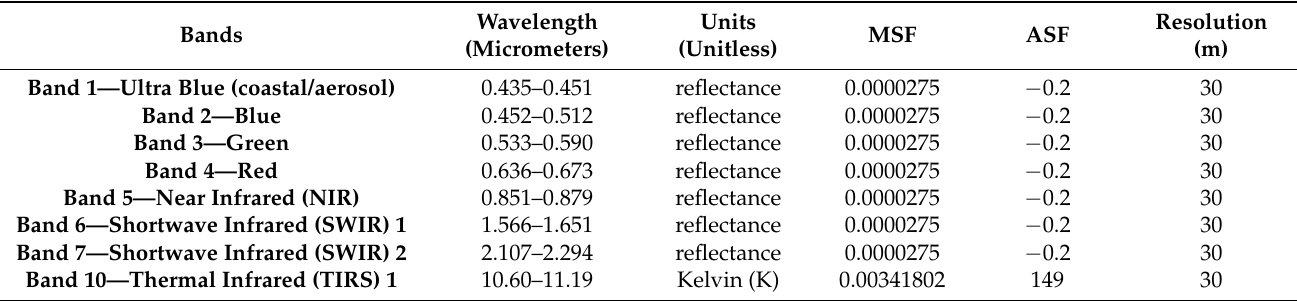
Table 2. The list of Landsat 8 L2SP product used bands.